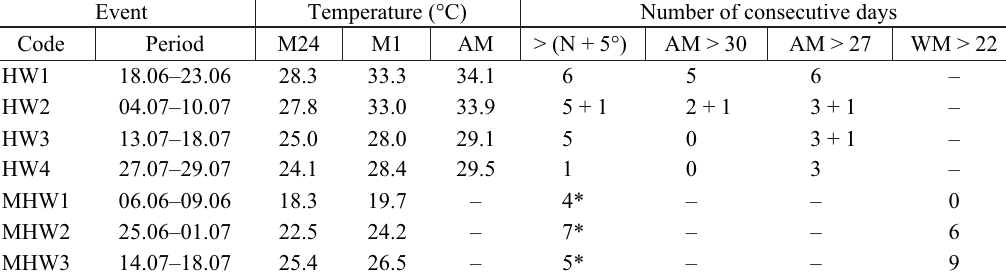
Event Temperature (°C) Number of consecutive days Code